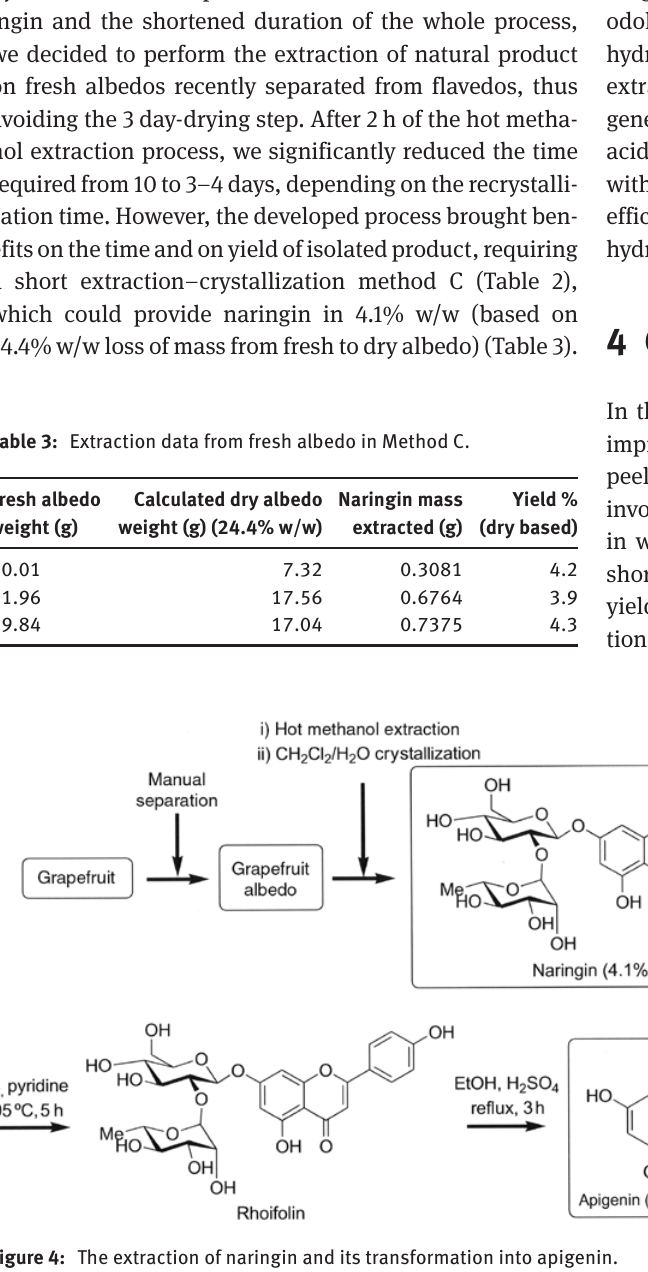
Figure 4: The extraction of naringin and its transformation into